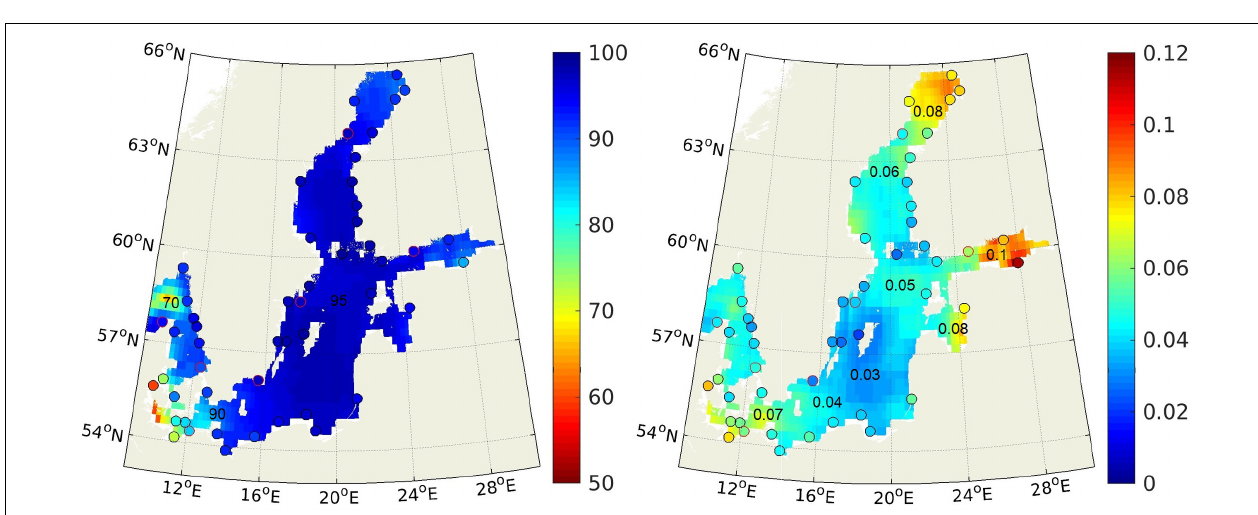
FIGURE 5 | Correlation (%, left ) and RMS differences (meters, right ) between SLV_TGval and the nearest neighboring point of SLV_SRM. Colored circles: validation stations. Black squares: TGin stations.